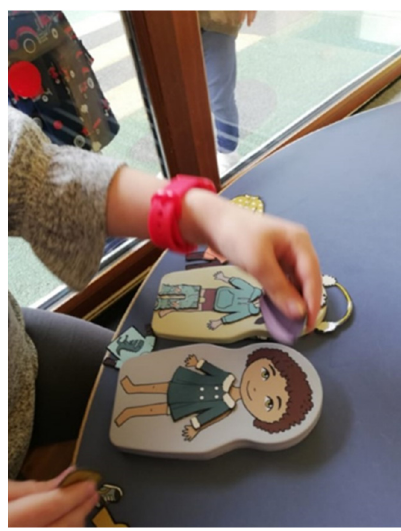
Int. J. Environ. Res. Public Health 2020 , 17 , x